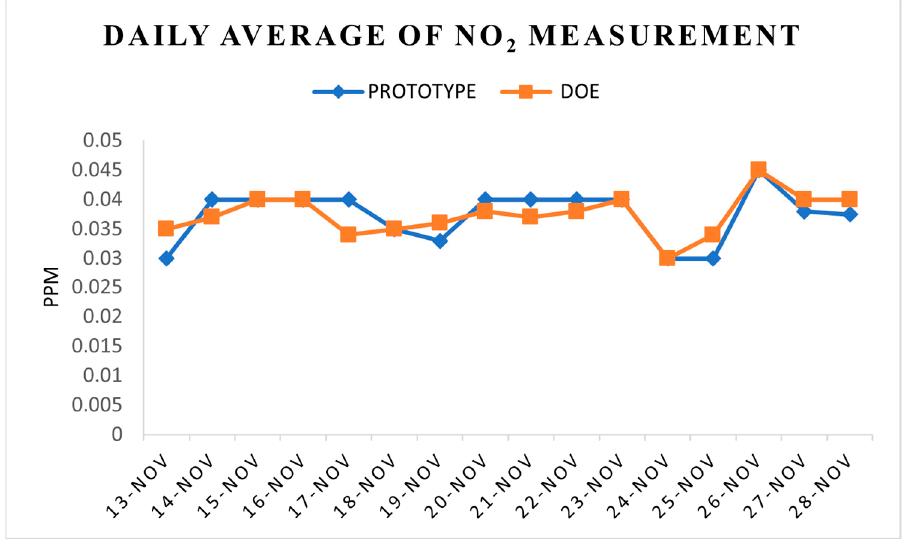
Figure 16. Daily average of NO 2 mass concentration.